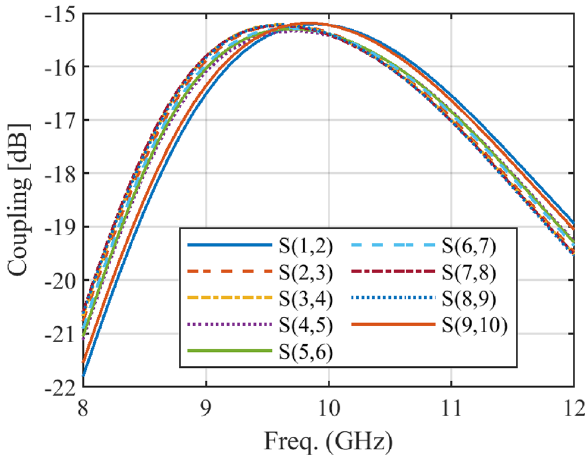
Figure 9. The simulated mutual coupling between different elements of the designed array with Taylor method.